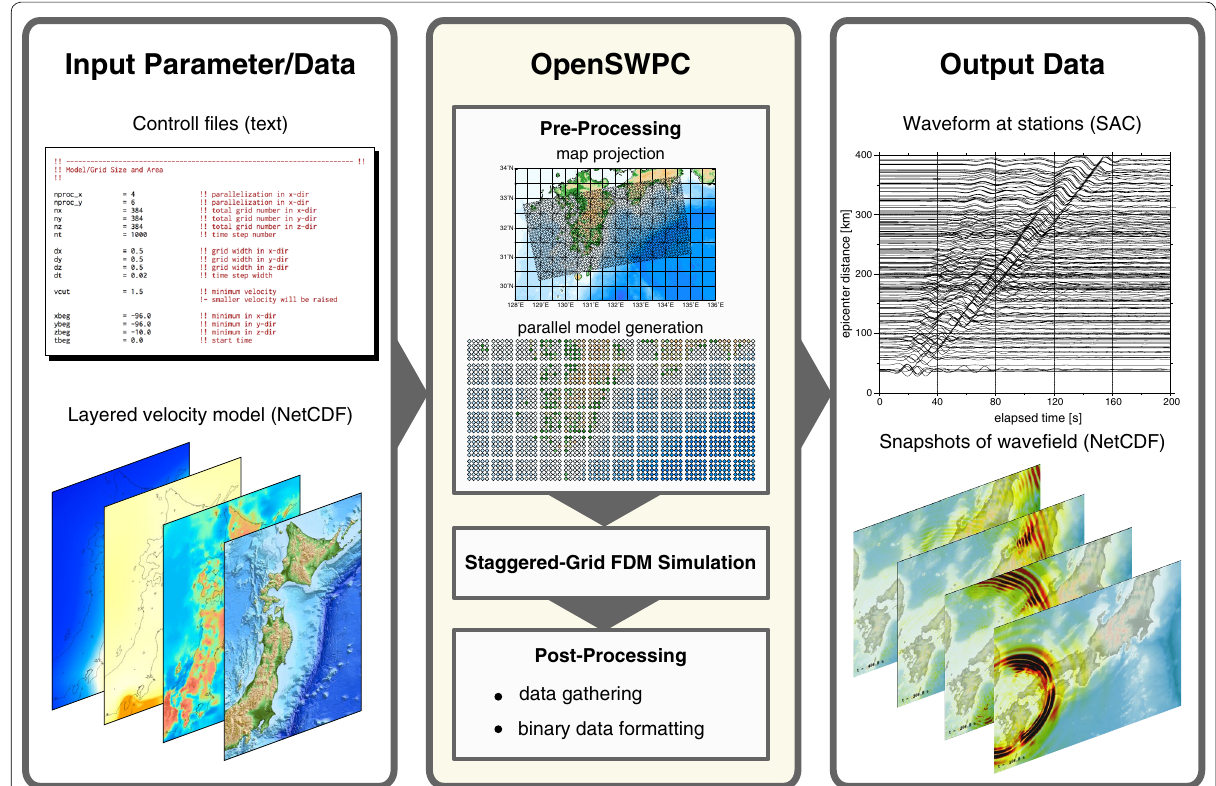
Fig. 1 A schematic illustration of the flow of the wave propagation simulation using